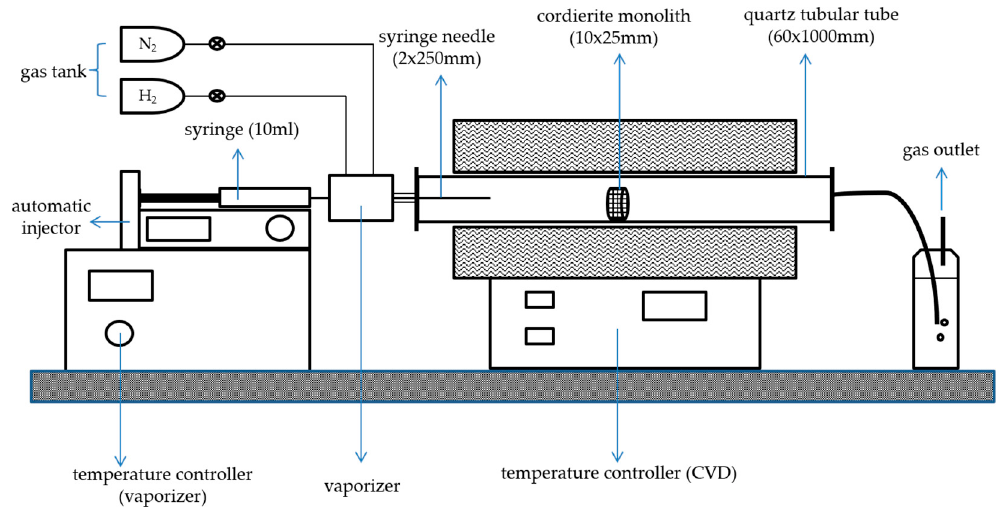
Figure 10. Schematic diagram of chemical vapor deposition (CVD) horizontal quartz reactor.